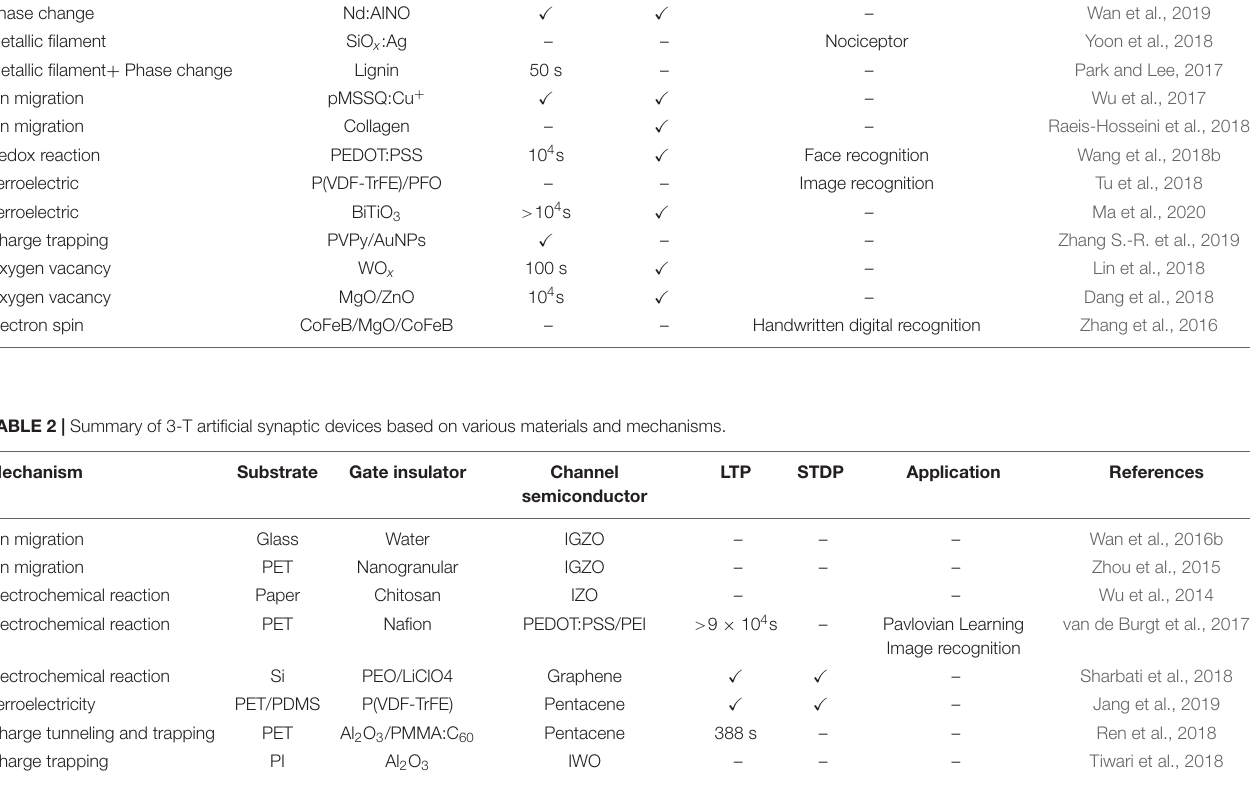
TABLE 1 | Summary of 2-T artificial synaptic devices based on various materials and mechanisms. Mechanism